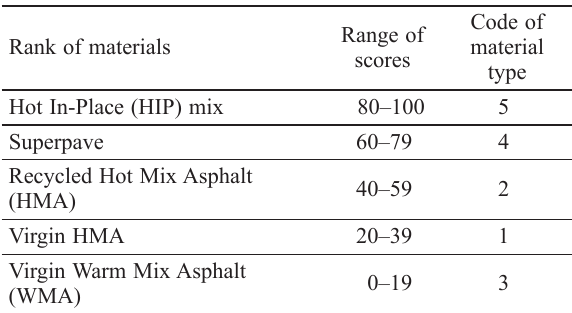
Table 9. The CM selection score table for materials